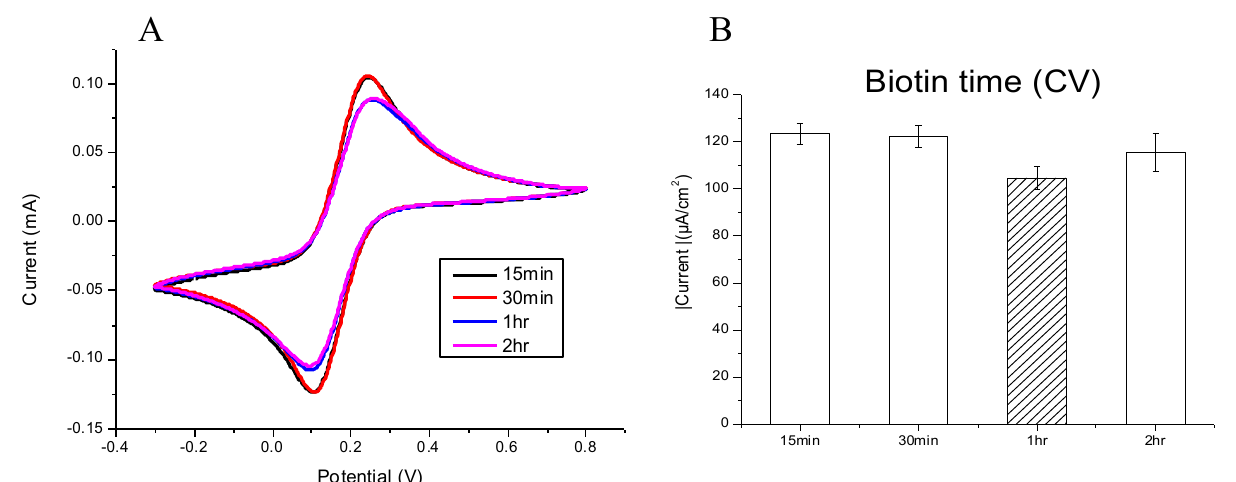
Figure 3. Observations of a range of time periods (15 min, 30 min, 1 h, and 2 h), the modified surface of SPCE reacted with the 5 μ m biotinylated capture probe at room temperature, and the currents measured by ( A ) CV and ( B ) biotinylated capture probe. The 1 h reaction time showed the best reduction potential value. The bar chart also shows the triple exam- inations with confidence intervals.